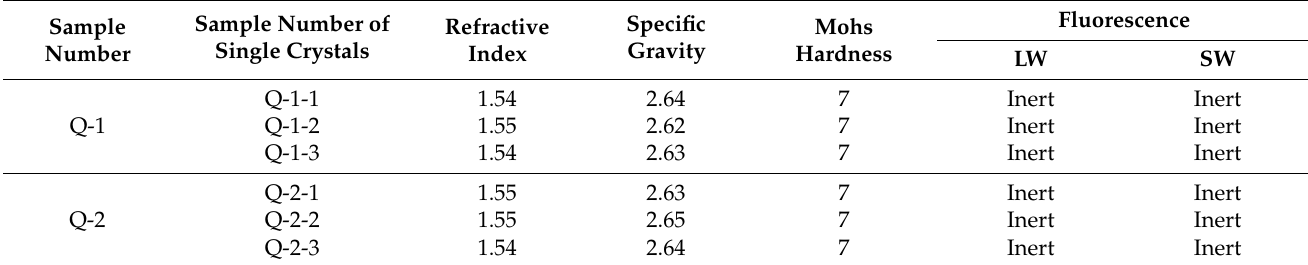
Table 1. Basic gemological properties of investigated regrown quartz crystal samples.